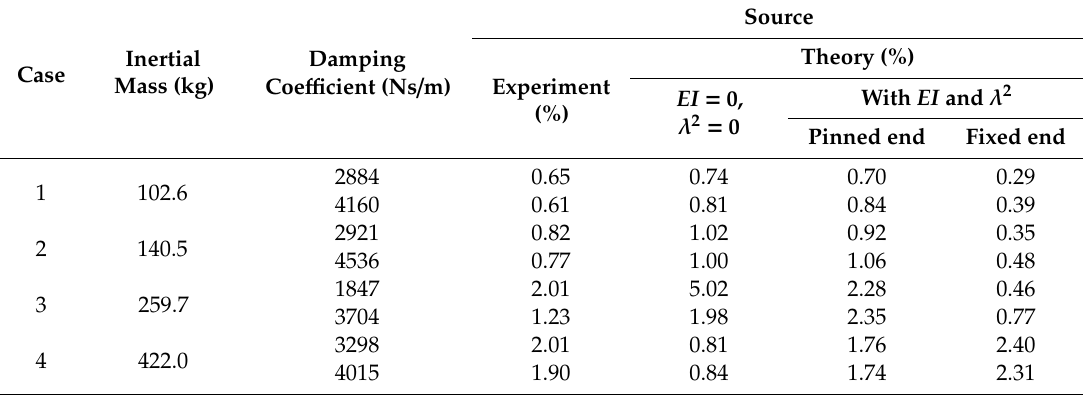
Table 3. The second supplemental modal damping ratio obtained in the theoretical calculation and experimental tests